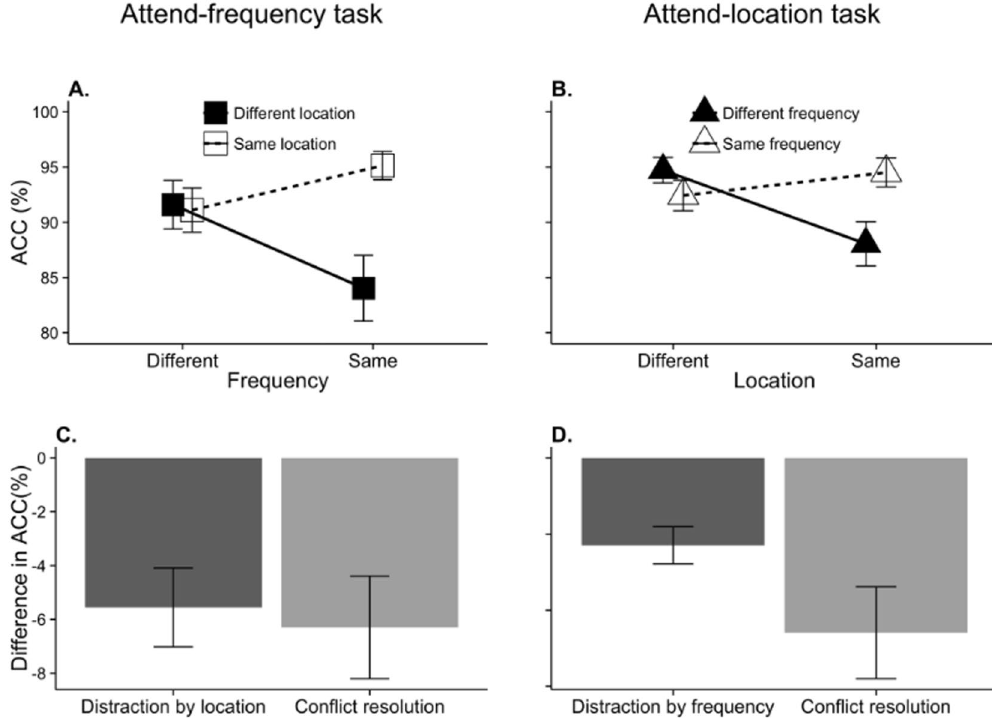
Figure 2. Group mean accuracy for the ( A ) attend-frequency and ( B ) attend-location TAiL tasks. Group mean measures of distraction and conflict resolution for the ( C ) attend-frequency and ( D ) attend-location TAiL tasks. The error bars represent the standard error of the mean.